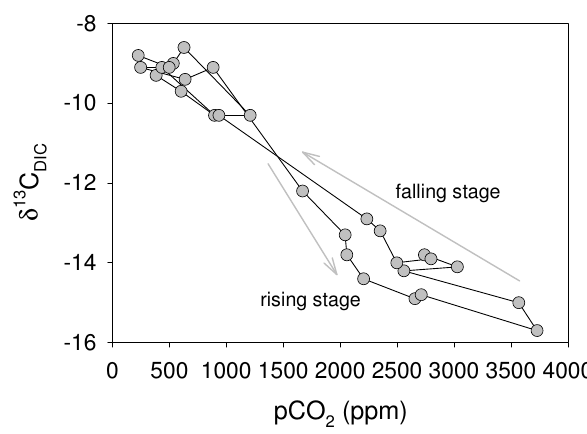
Fig. 12. Covariation between p CO 2 values and the carbon stable isotope composition of dissolved inorganic carbon, for the Ouban- gui River at Bangui between March 2010 and March